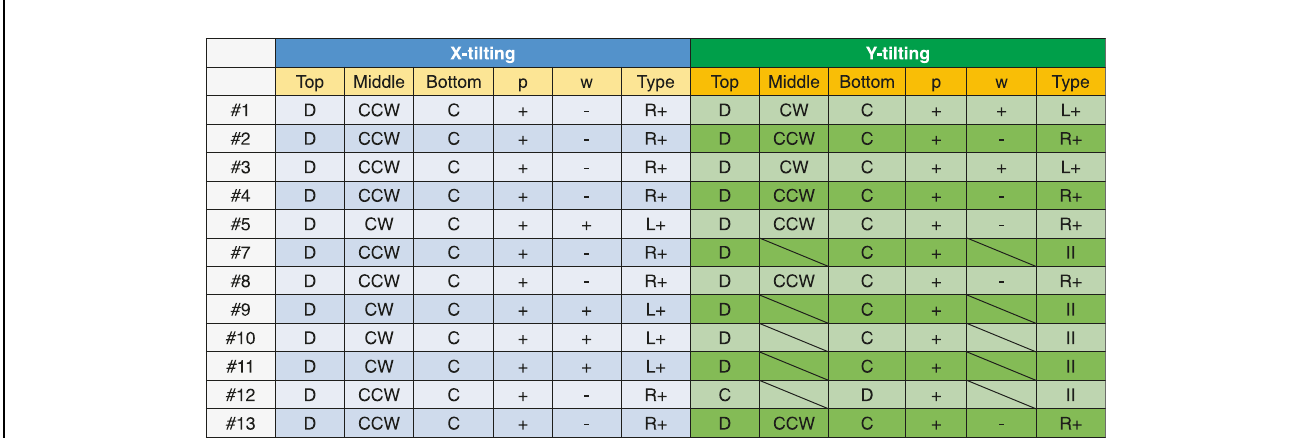
Table 1 | Comparison of a spin con fi guration of skyrmion bubbles between x-tilting and y-tilting